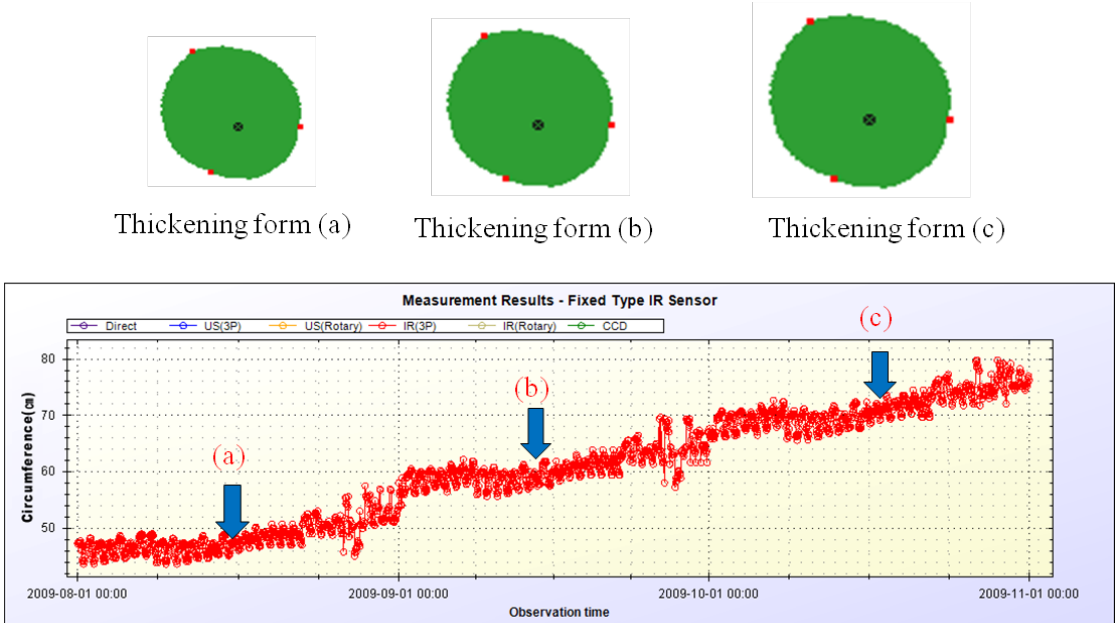
Figure 24. Measurement results obtained using the fixed-type measurement